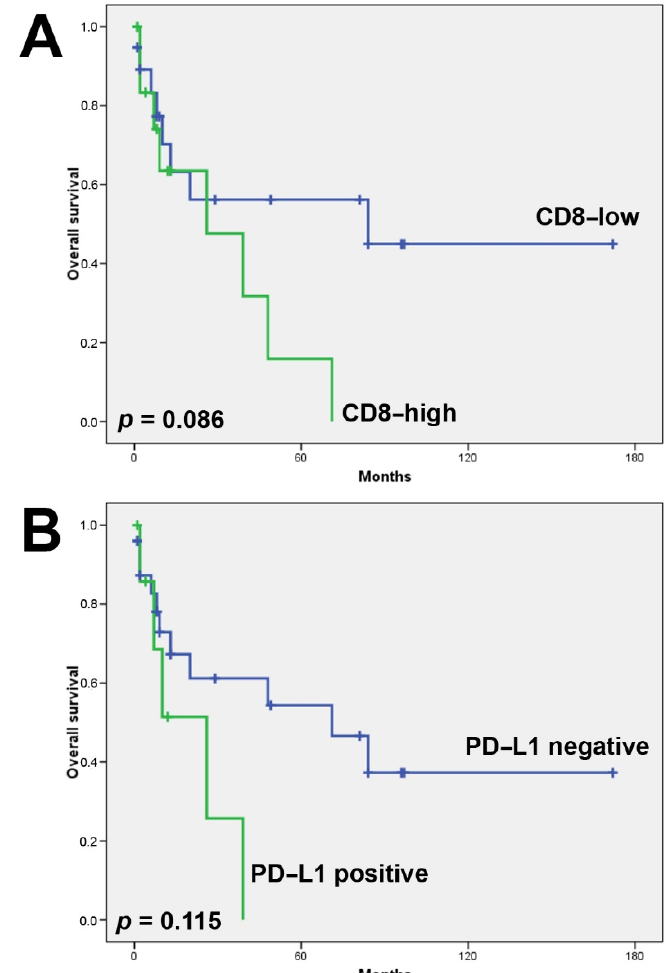
Figure 4. Kaplan–Meier overall survival analysis according to CD8+ TIls ( A ) and according to PD-L1 expression ( B ).